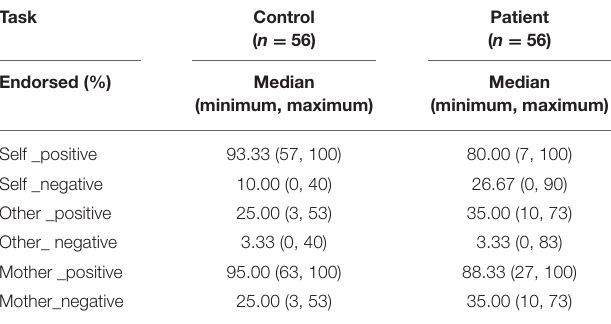
TABLE 2 | Encoding endorsed data for healthy controls and first-episode schizophrenia. Task